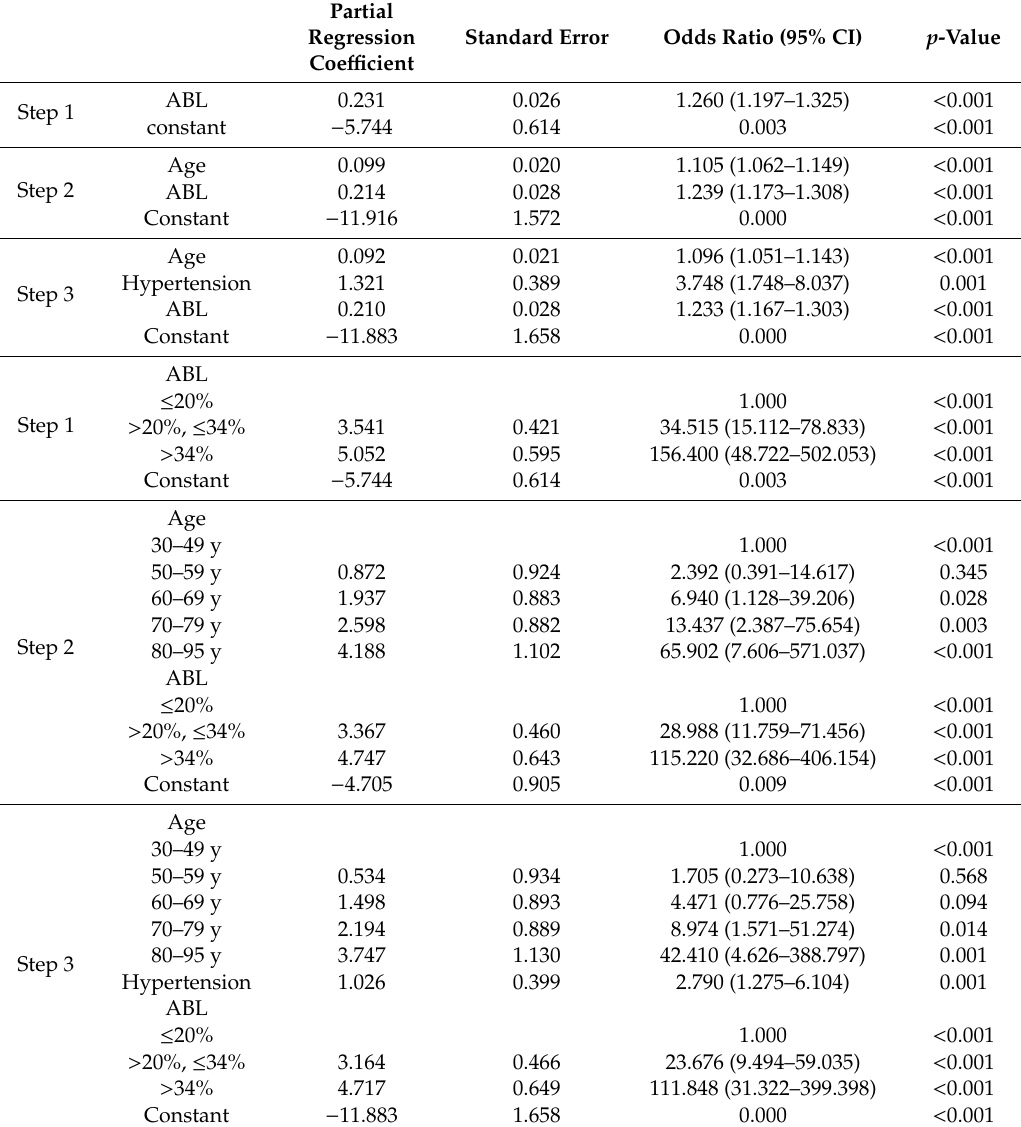
Table 3. Factors associated with carotid artery calcification and the rate of alveolar bone loss evaluated by multivariate logistic regression analysis using forward selection.